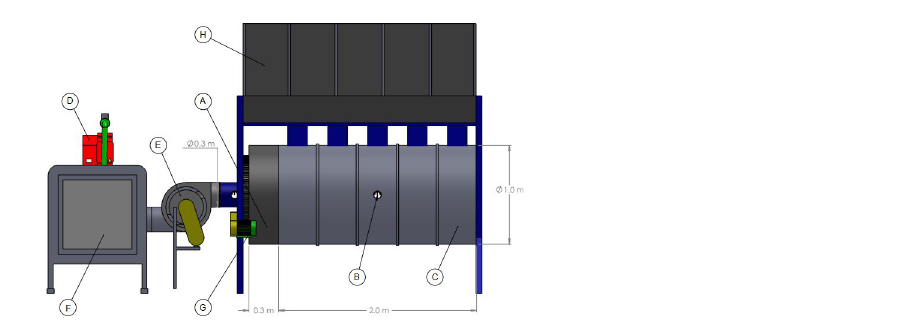
Fig 2. Heated air distribution and movement diffuser (A), air flow and temperature meter (B), cylindrical and rotary drying chamber (C), gas burner (D), air fan (E), flame generator and air heating (F), electric motor to move the diffuser and drying chamber (G), dryer loading (H).